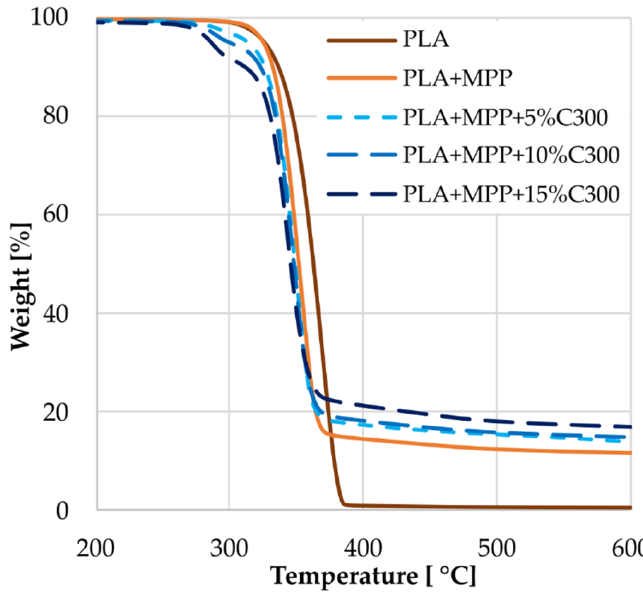
Figure 1. TGA results of the C300 containing PLA samples. Table 3. TGA results of the composite samples with different neat cellulose